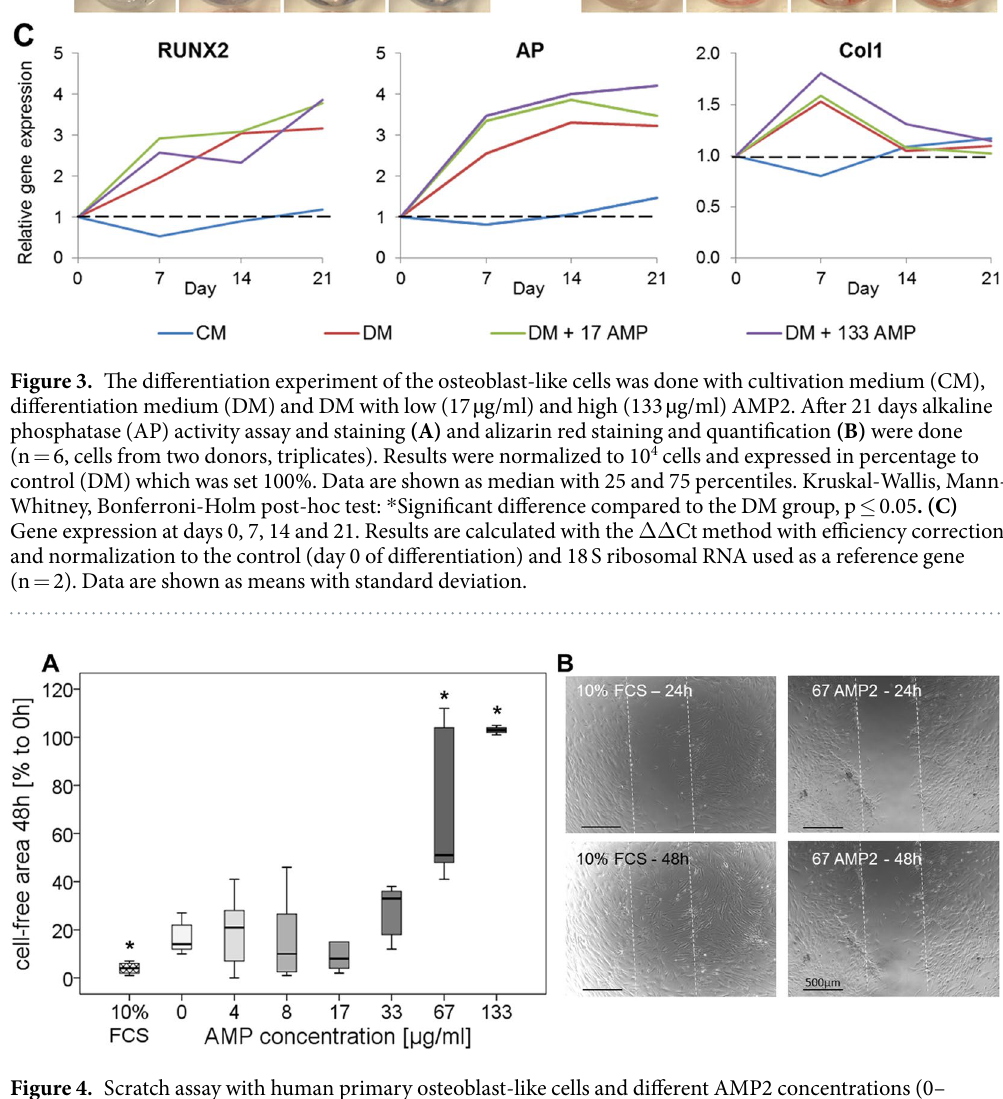
Figure 4. Scratch assay with human primary osteoblast-like cells and different AMP2 concentrations (0– 133 µ g/ml). Measurement of the gap was directly done after performing the scratch and after 24 and 48 hours incubation (n = 3–9, cells from one donor). ( A ) The cell-free area after 48 hours is shown in percentage of the gap compared to time point 0 hours ( = 100%). Positive control: CM with 10% FCS. Data are shown as median with 25 and 75 percentiles. Kruskal-Wallis, Mann-Whitney, Bonferroni-Holm post-hoc test: * Significant difference compared to group treated with 0 µ g/ml AMP, p ≤ 0.05. ( B ) Exemplary pictures of positive control and 67 µ g/ml AMP2 after 24 and 48 hours. The dotted lines mark the scratch. Scale bar 500 µ